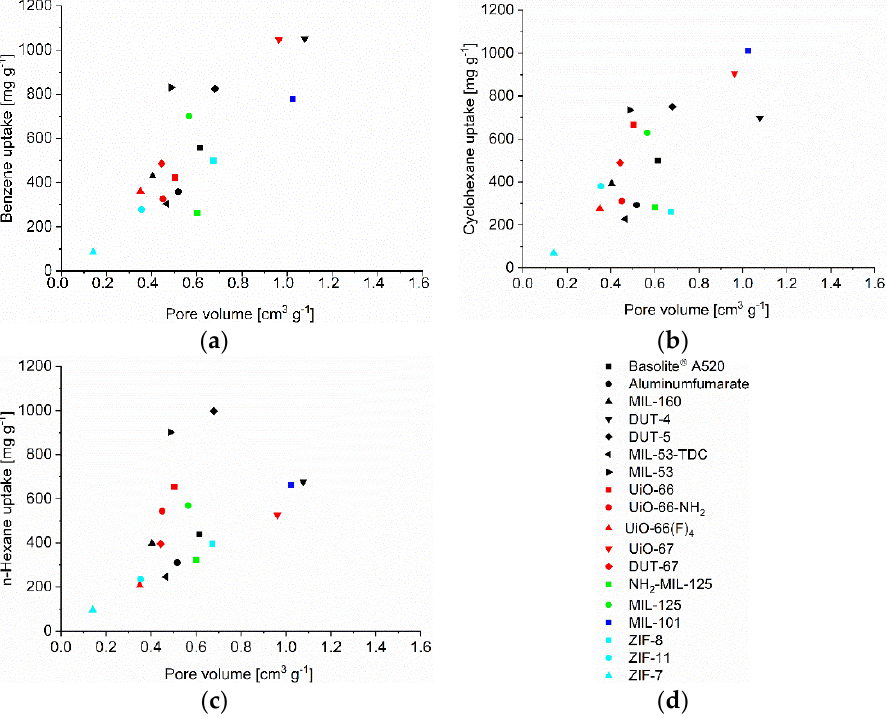
Figure 5. C 6 -VOC uptake at p p 0 − 1 = 0.9 (293 K) versus pore volume (NLDFT and total pore volume, Table S2) for ( a ) benzene, ( b ) cyclohexane and ( c ) n -hexane with ( d ) legend to the figures.